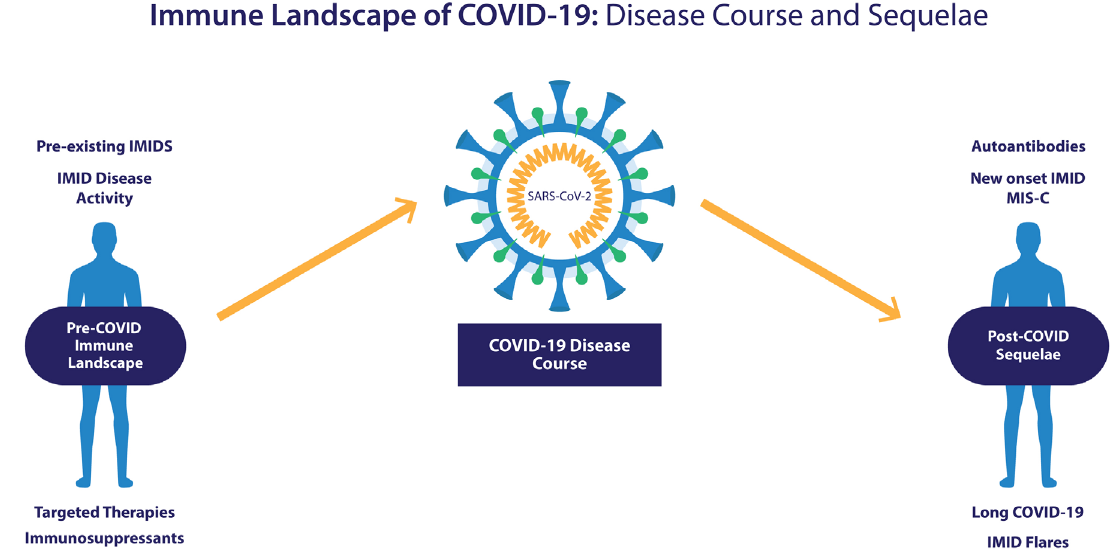
Figure 1. The evolving immune landscape of COVID-19: Baseline characteristics implicated in disease course, and immune-mediated sequelae. The clinical course of COVID-19 infection may be influenced by the immunologic milieu and the immune-based therapies of patients with pre-existing IMIDs who become infected (left). In addition, the infection itself may influence the clinical course of patients with IMIDs (ie, induce flares) or the development of autoimmune laboratory phenomenon and/or new IMIDs as well as potentially contributing to some post COVID-19 sequelae such as long COVID-19 symptomatology (right). Abbreviations: IMID, immune-mediated inflammatory disease; MIS-C, multisystem inflammatory syndrome in